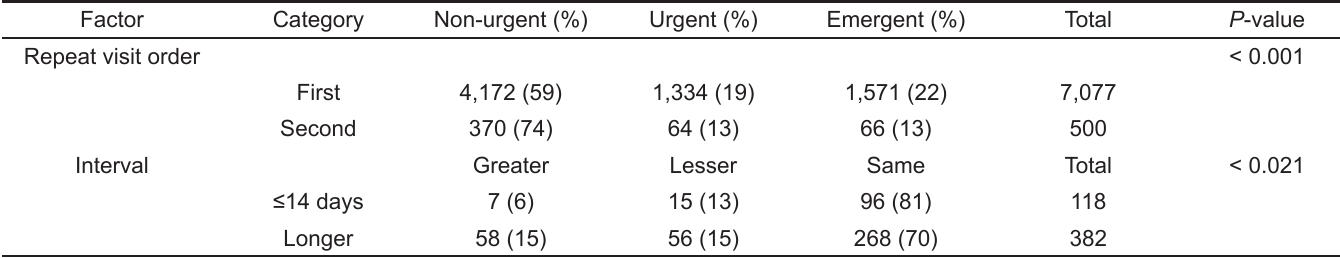
Table 4. Comparative urgency of first and second visits.